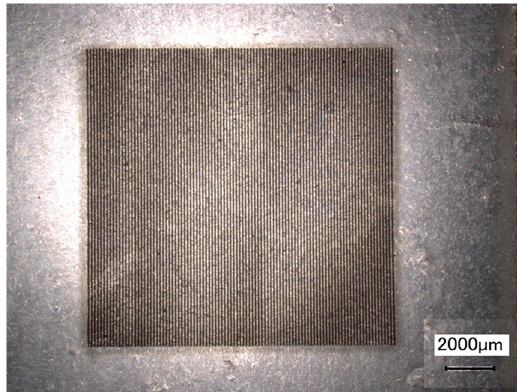
Figure 10. Parallel gratings fabricated on a rubber tensile specimen before load.